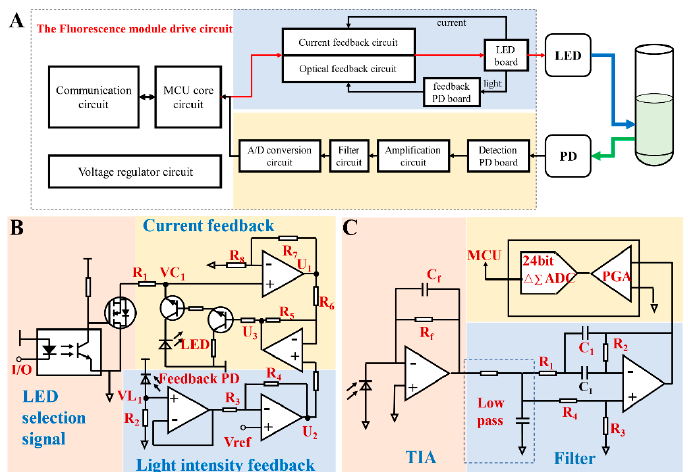
Figure 3. Overall circuit of the fluorescence detector: ( A ) a principle block diagram of the drive cir- cuit; ( B ) the current–light dual negative feedback LED driving circuit schematic, including three parts: (1) current feedback, (2) light intensity feedback, and (3) LED selection signal; ( C ) photoelec- tric processing circuit schematic, including: transimpedance amplifier (TIA), filter, and analog-to- digital (A/D) conversion.